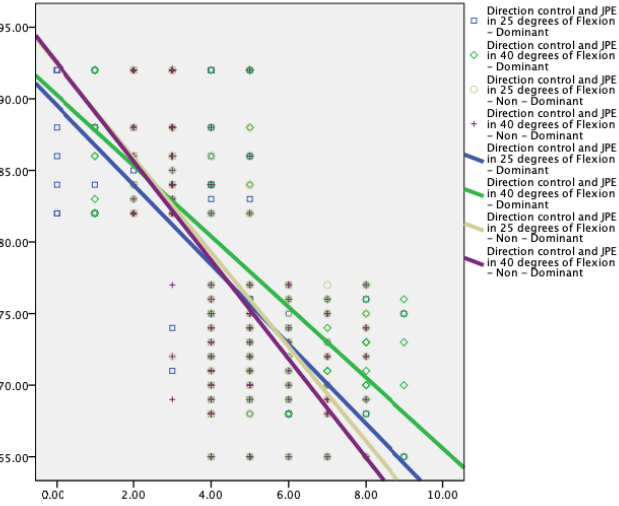
Figure 7. Relationship between direction control (%) and knee joint position error at 25° and 40° of fl exion in dominant and nondominant legs. Knee proprioception showed statistically signi fi cant moderate to strong correlations with the reaction time (r = 0.60 to 0.68, p < 0.001), maximum excursion (r = − 0.28 to − 0.38, p < 0.001), and direction control (r = − 0.59 to − 0.65, p < 0.001) parameters of the limits of